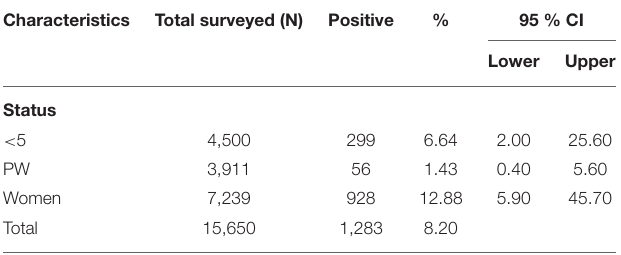
TABLE 1 | Demographic characteristics of residents surveyed in Bannu districts ( n = 15,650). Characteristics